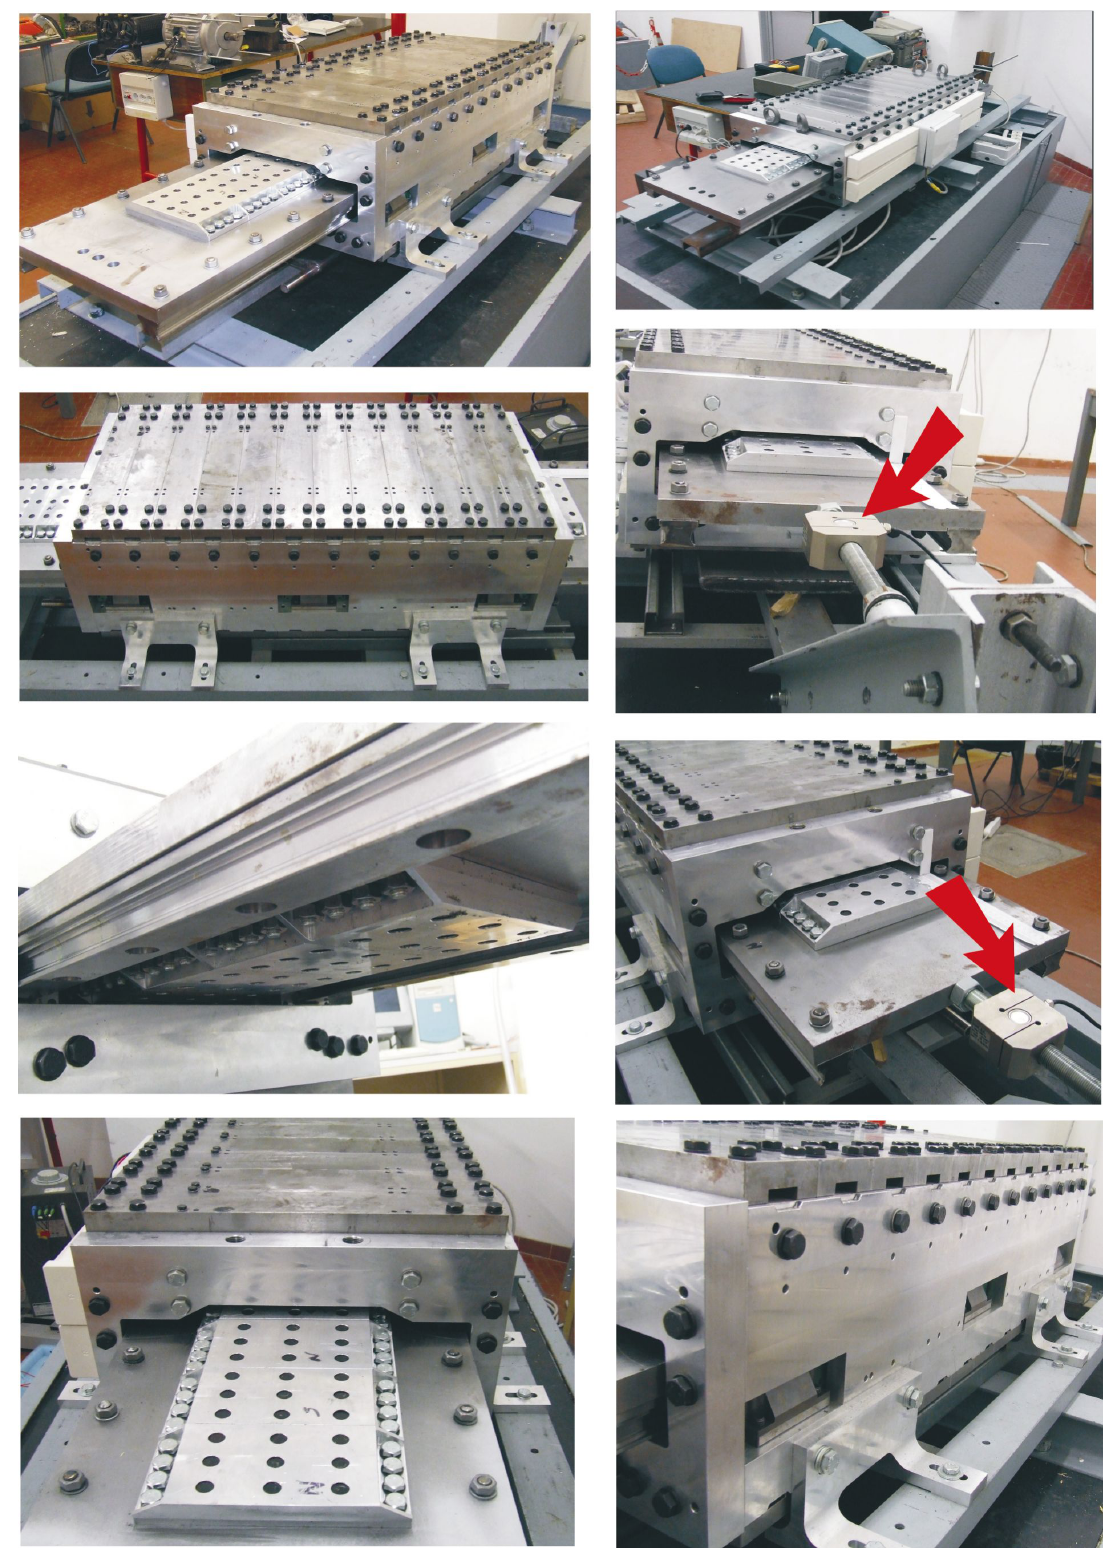
Figure 27: The linear electromagnetic actuator manufactured and tested (the red arrow indicate the force sensor to measure the thurst fur- nished by the